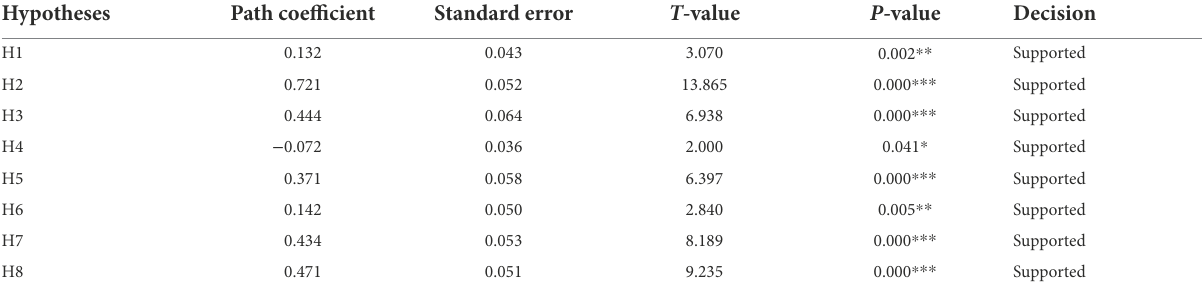
TABLE 12 Path analysis and hypothesis testing (first model).